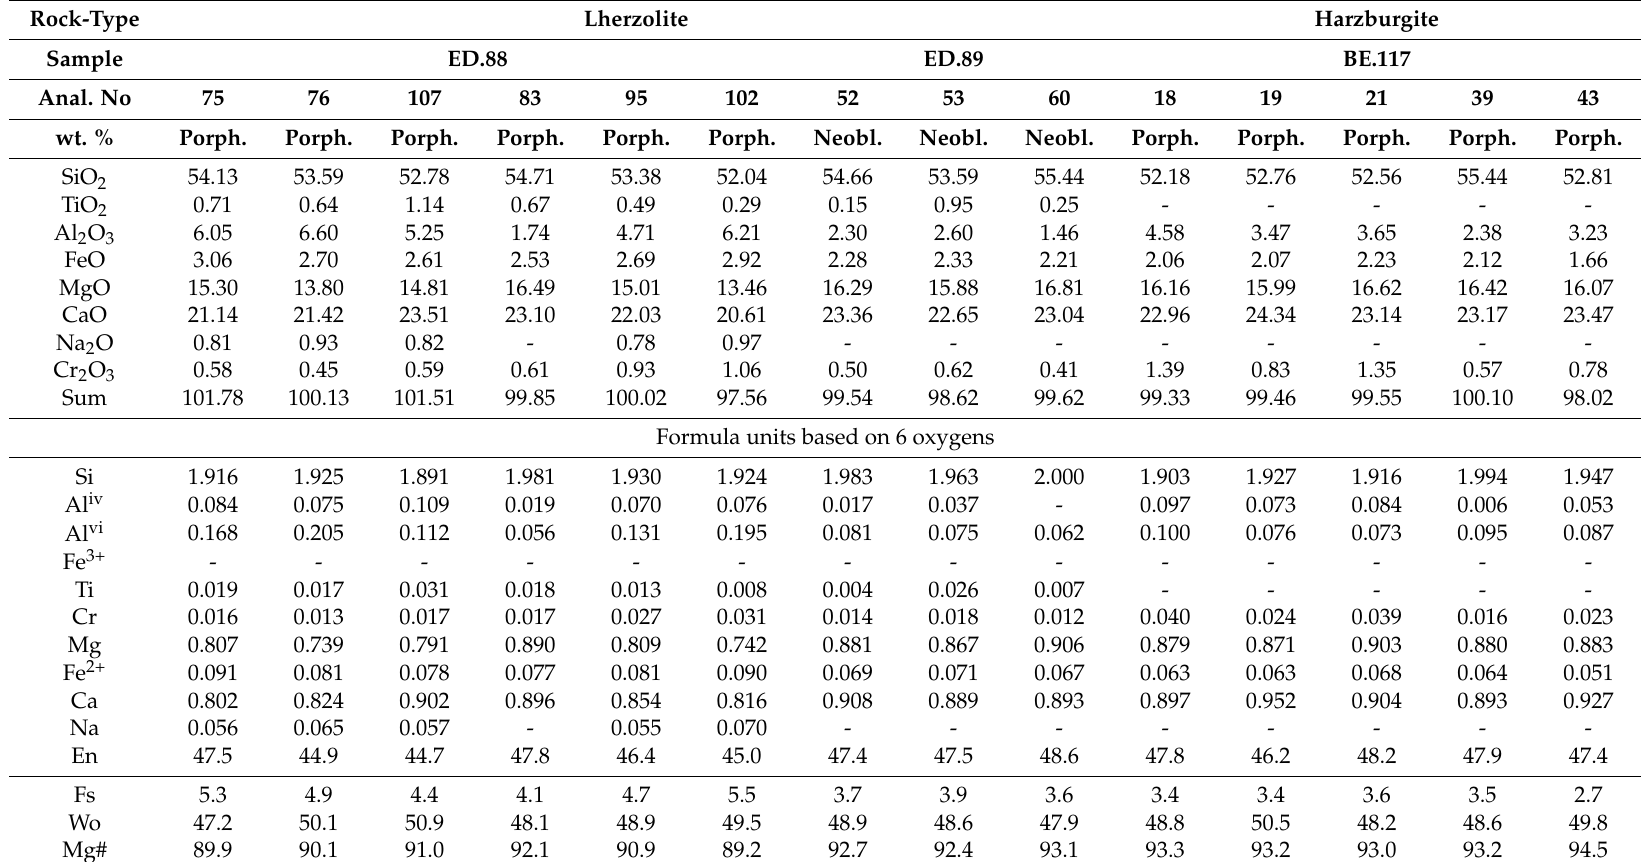
Table 2. Representative electron microanalyses of clinopyroxenes from peridotites of the Edessa ophiolitic complex (-: below detection limit).